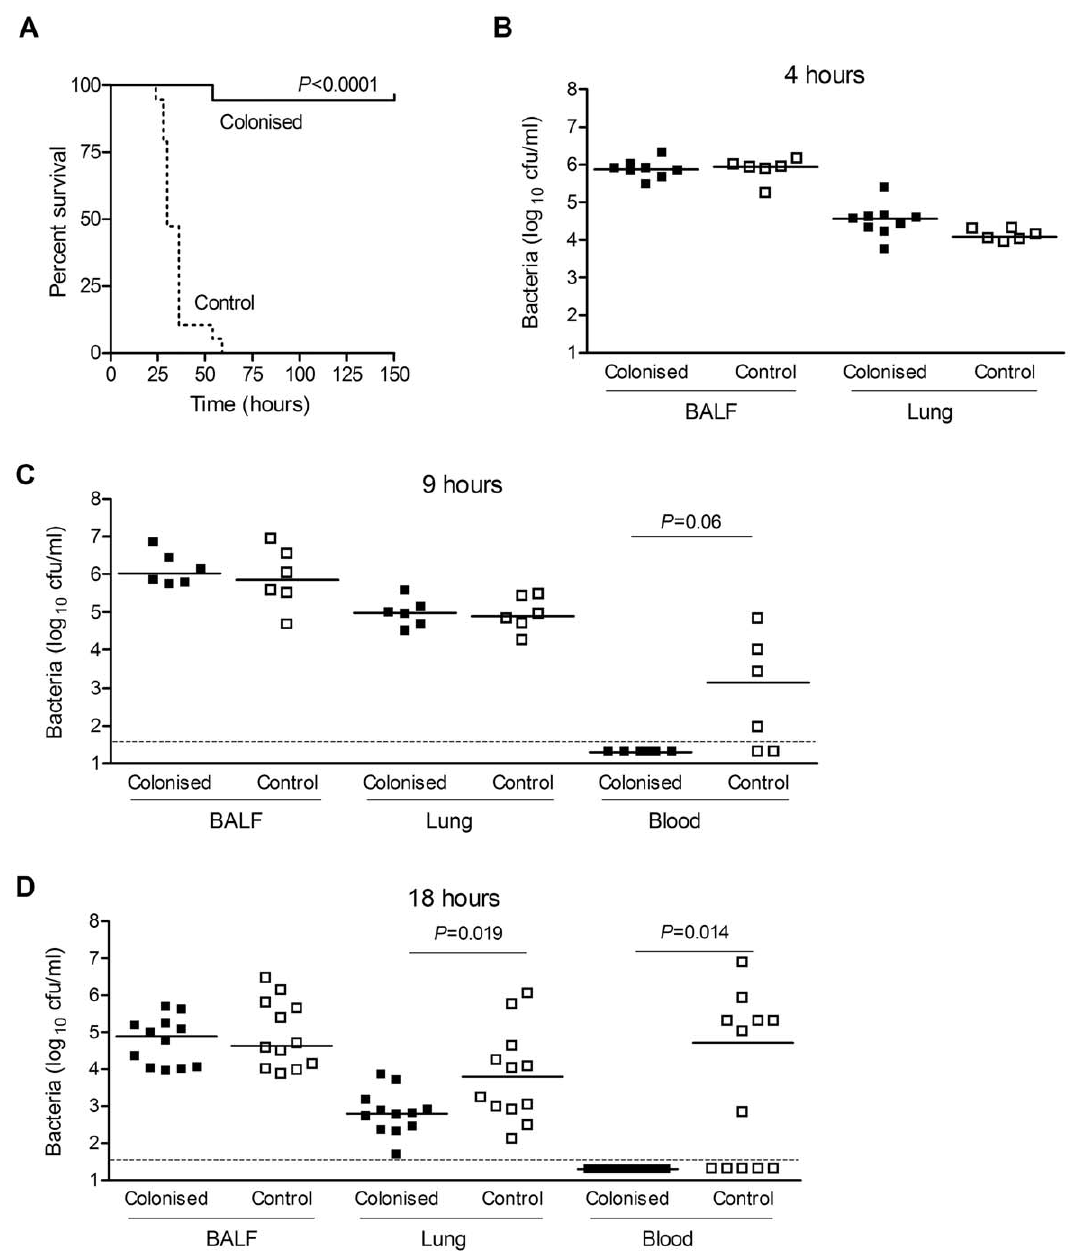
Figure 2. Effects of prior colonisation on progression of subsequent S.pneumoniae pneumonia. (A) Kaplan-Meier survival curves of previously colonised or control CBA/Ca mice following pneumonia challenge with 10 7 cfu D39 S. pneumoniae in 50 m l PBS on day 28 (n=18 or 19). (B–D) Bacterial cfu in BALF, lung or blood of colonised or control mice at (B) 4 h, (C) 9 h or (D) 18 h following pneumonia challenge. Each symbol represents results for an individual mouse and bars the median for each group. The dotted line is the limit of detection. Significance of the difference in bacterial numbers recovered from lungs of colonised and control mice was assessed by Mann-Whitney U-test. Significance of differences in presence or absence of bacteraemia was assessed by Fisher exact test. Data at 18 h are pooled from two experiments with similar